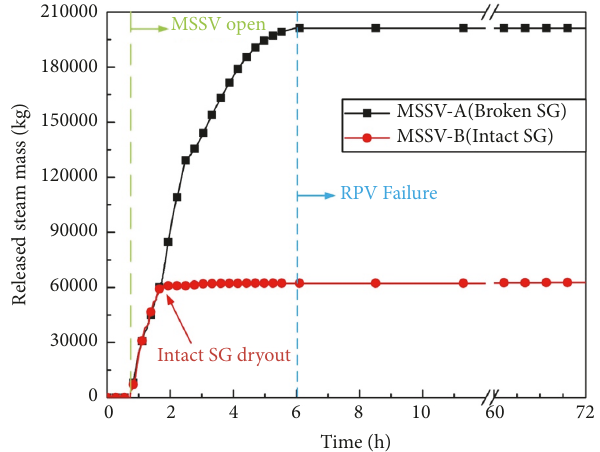
Figure 10: Pressure of the RCS and SGs in the ICRV-CNMT case.